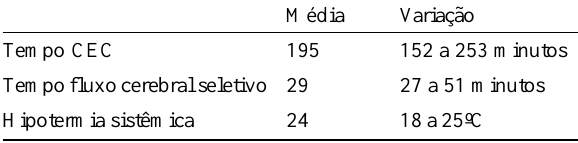
Fig. 1 - Desenho esquemático da CEC. A - Tubo de PTFE. B - Conector 3/8 - 1/4 polegada. C - Linha arterial. D - Rolete. E - Linha venosa. F - Cânula venosa de duplo estágio.